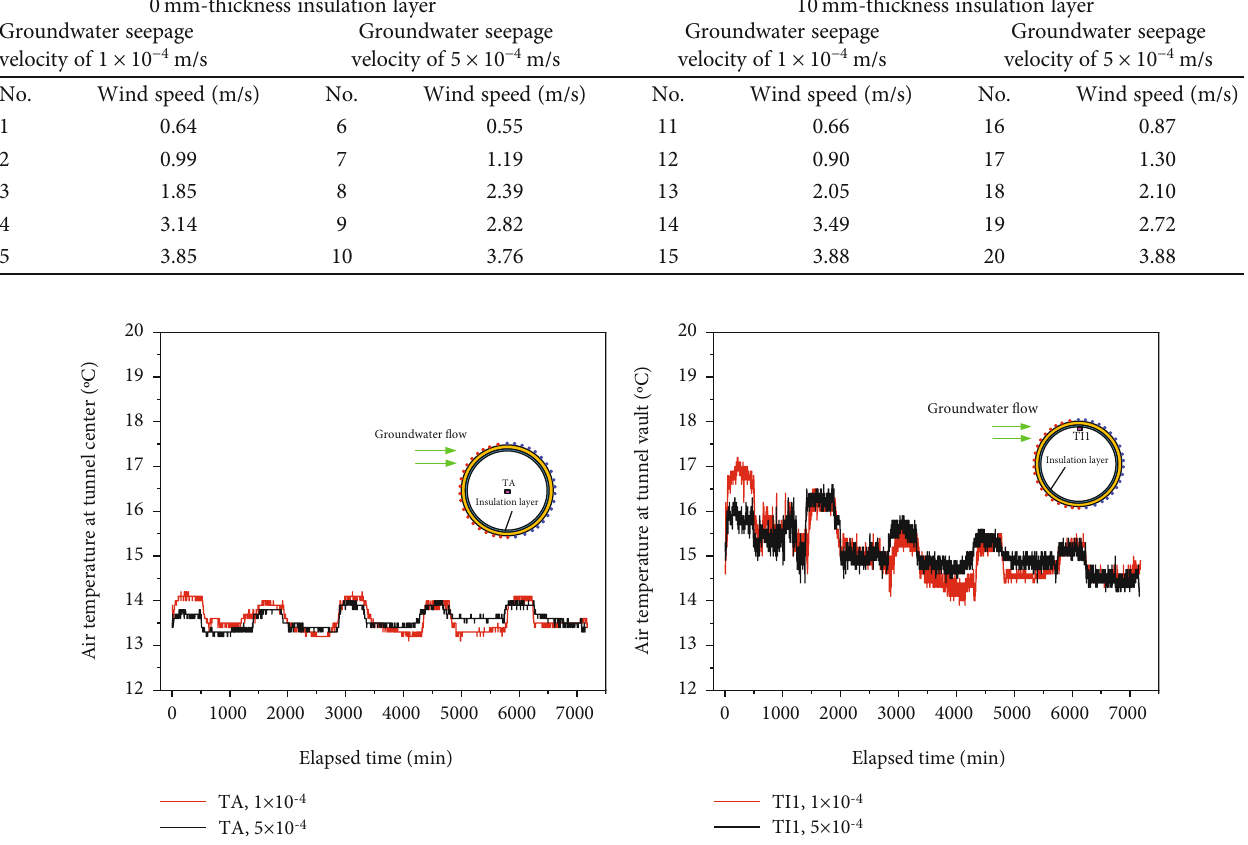
Table 2: The detailed design scheme of thermal response tests of the energy tunnel model.